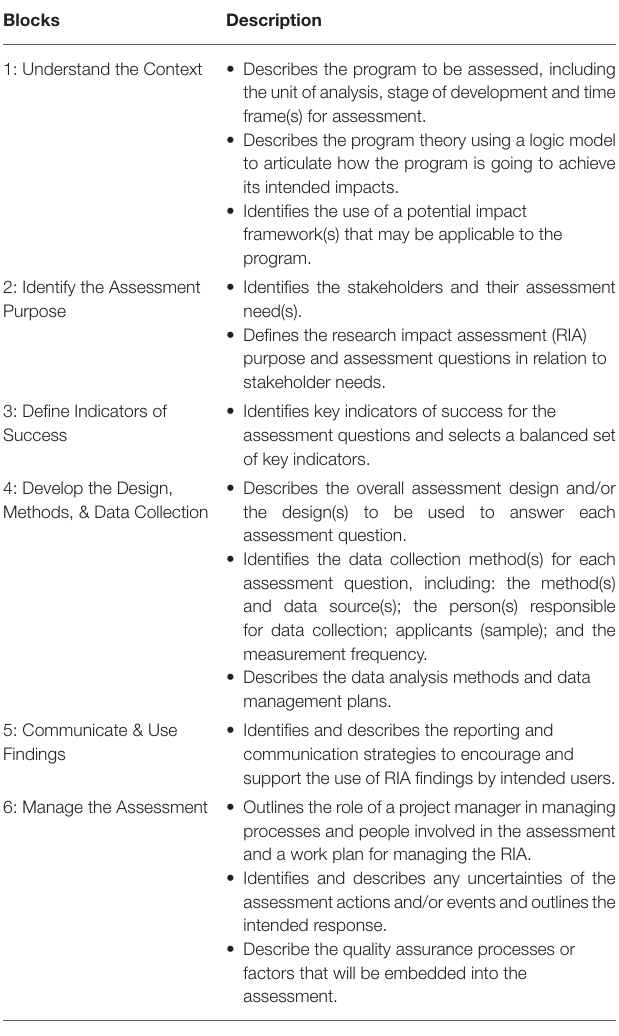
TABLE 2 | The Six-Block Protocol of Research Impact Assessment. Blocks